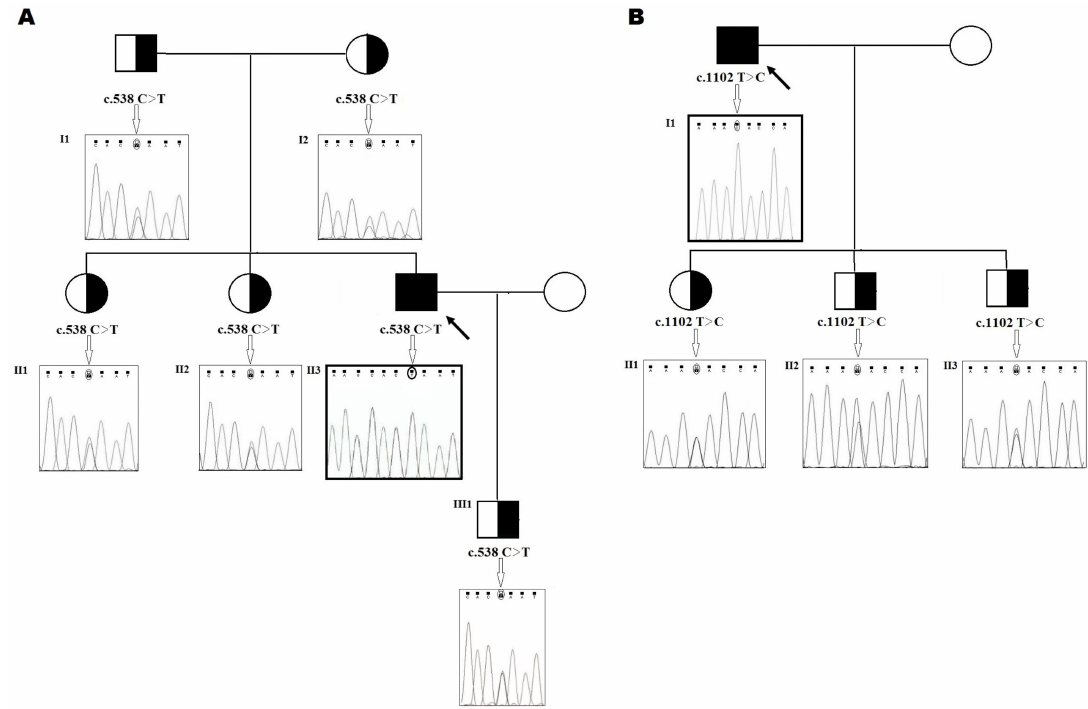
Figure 2. ( A ) Family pedigree of the patient with afibrinogenemia. Electropherogram of the homozygous mutation in exon 4 of the FGB gene (c.538C>T); ( B ) Family pedigree of the patient with hypofibrinogenemia. Electropherogram of the homozygous mutation in exon 7 of the FGB gene (c.1102T>C). The black filled-out symbol (Black Square) with an arrow represents the homozygous patient. The half-filled-out symbols with right half black represent the genotypically heterozygous family